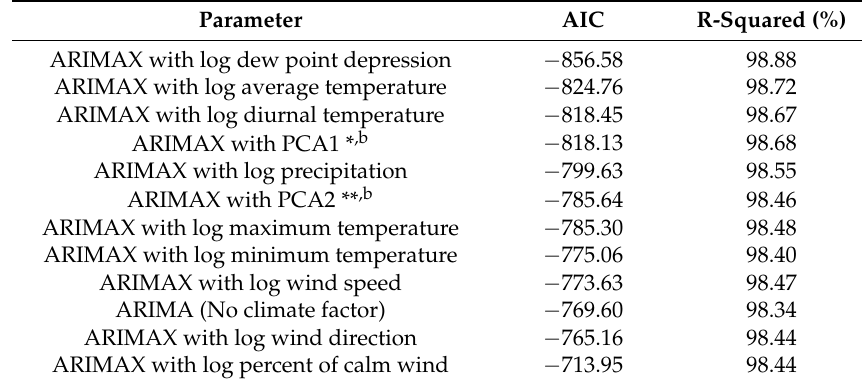
Table 2. Akaike’s information criterion (AIC) results and R-Squared of model fittings with meteorological parameters input series for the logarithm of water consumption in Las Vegas during 1990–2009 a